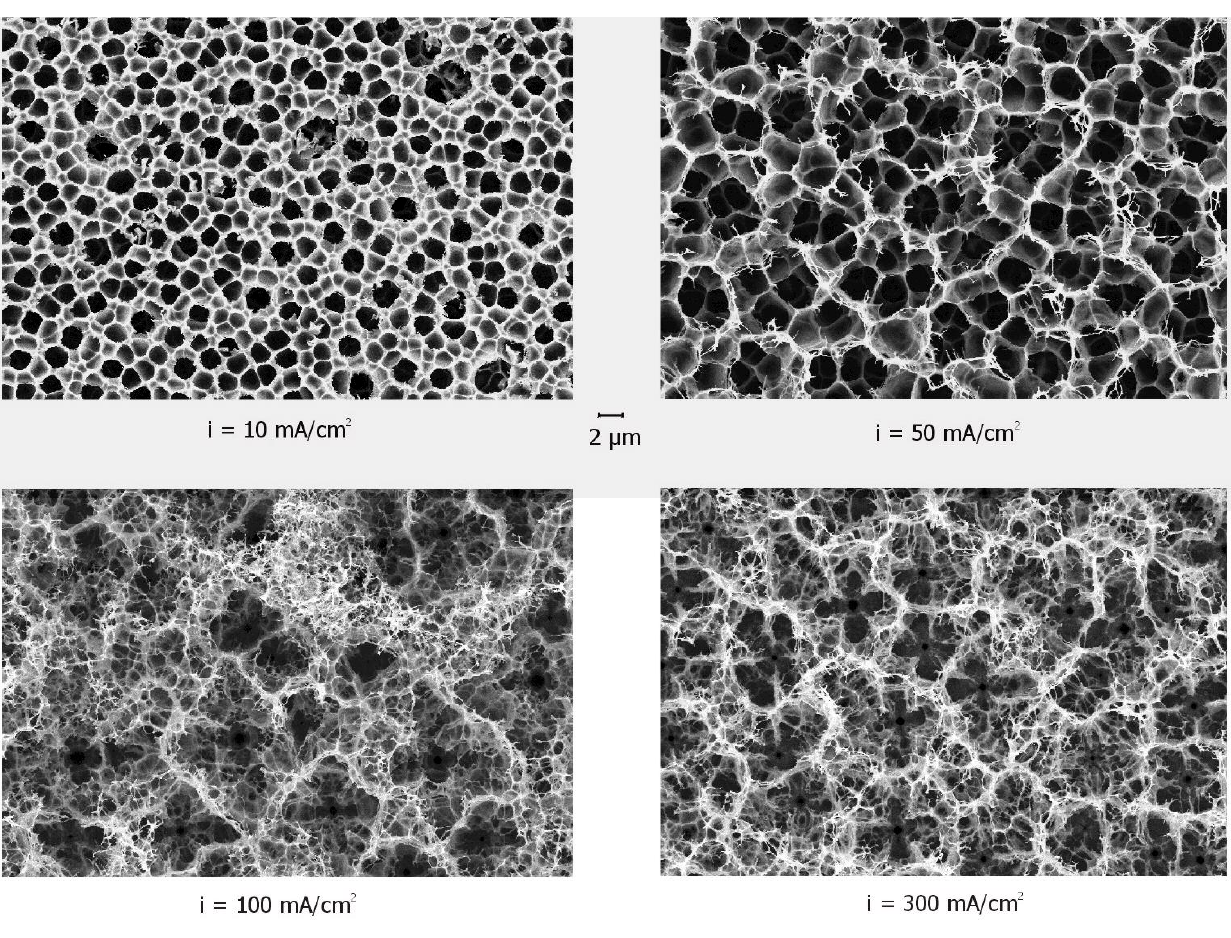
Figure 3. SEM top view of macroporous silicon samples, etched with current densities between 10 mA/cm 2 and 300 mA/cm 2 . When using low current densities (10 mA/cm 2 - 50 mA/cm 2 ), an uniform distribution of circular pores is observed. An increased pore diameter can be achieved with higher current